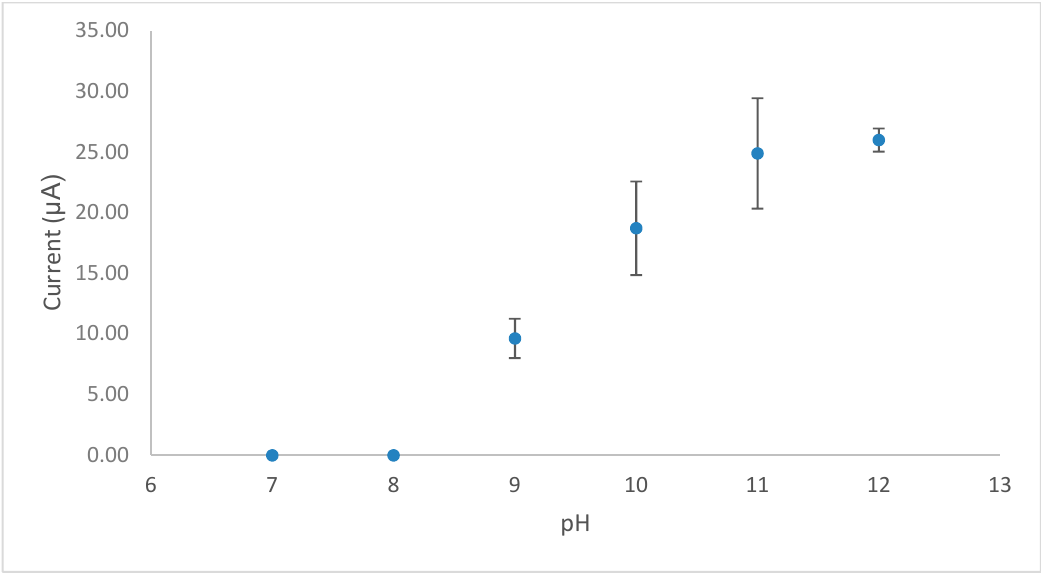
Figure 2. A plot of cyclic voltammetric peak current vs. pH for vitamin B1 in 0.1 M PBS.